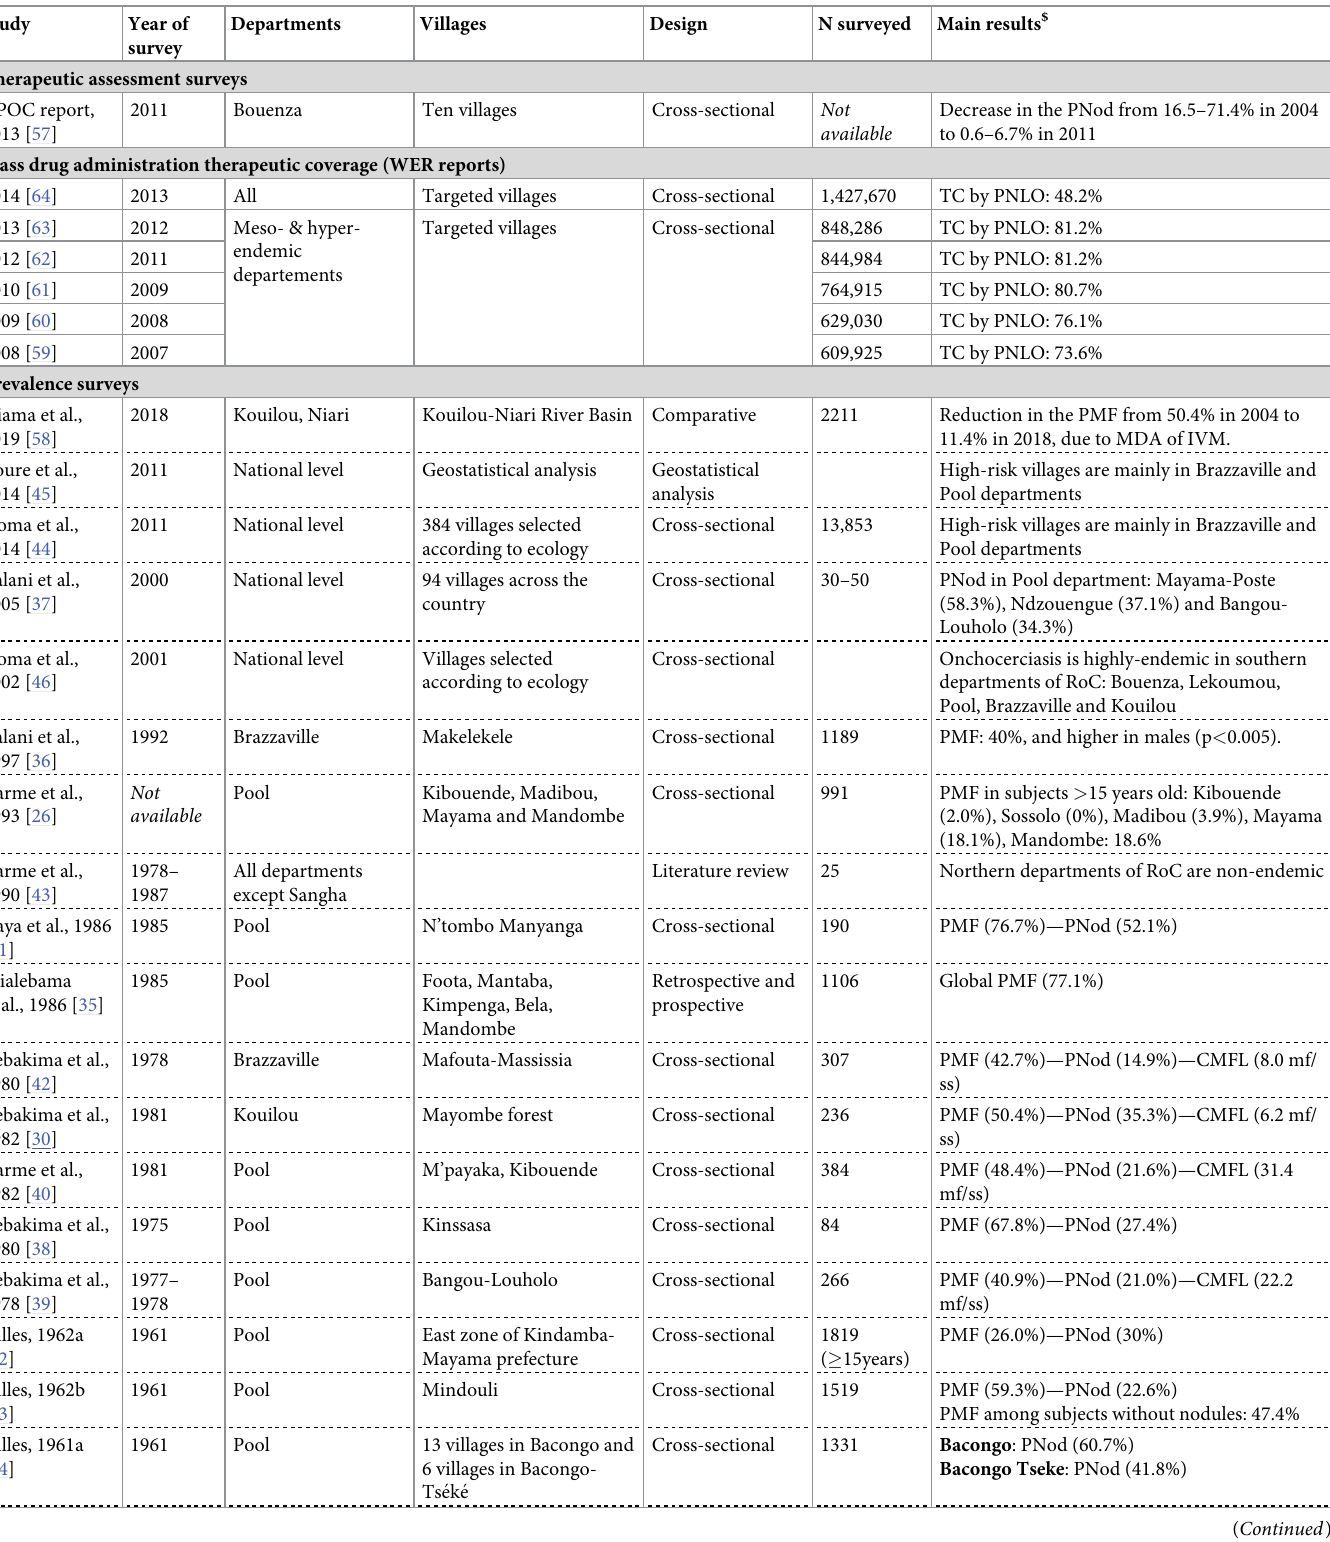
Table 1. Summary of the included epidemiological studies and reports for onchocerciasis (N =